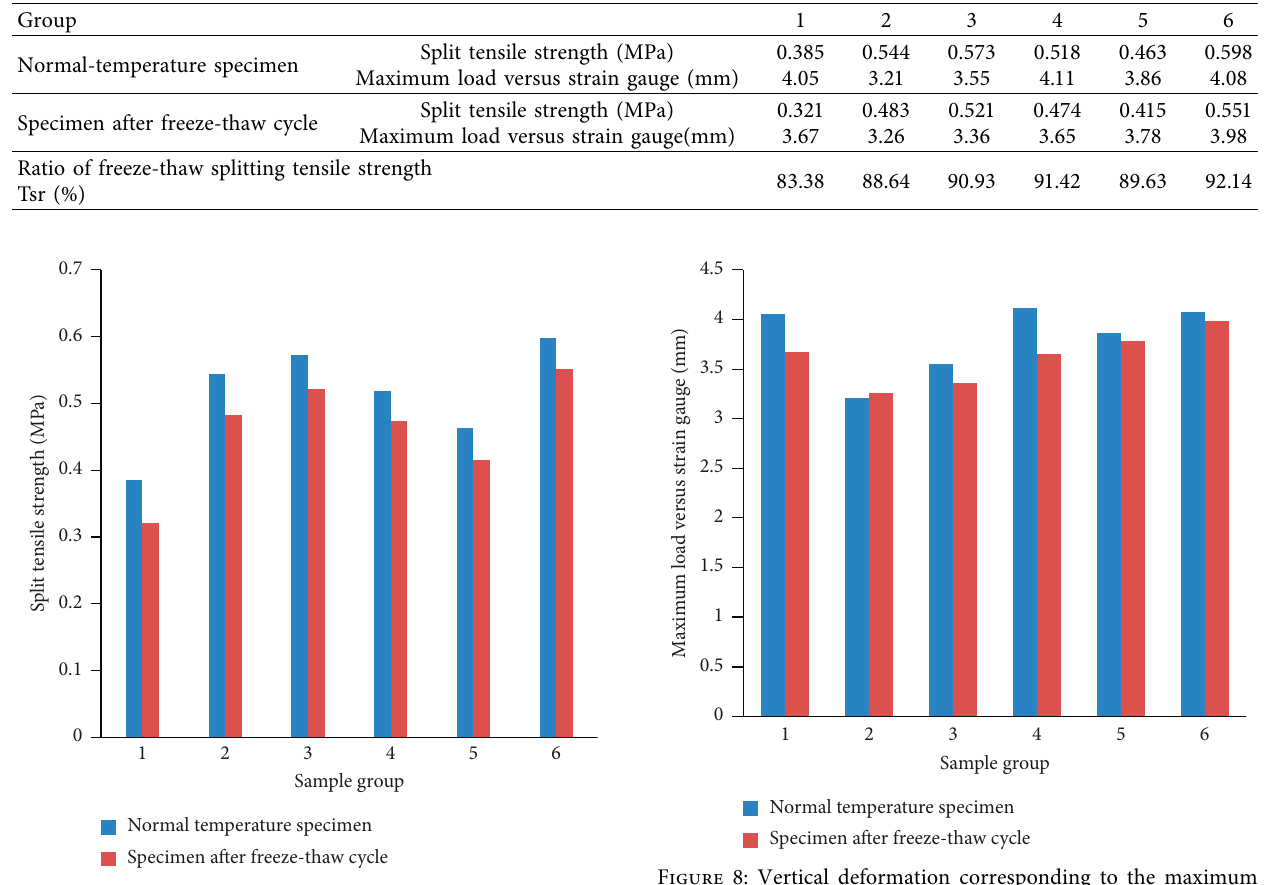
Figure 7: Freeze-thaw splitting tensile strength ratio of each mixture specimen.